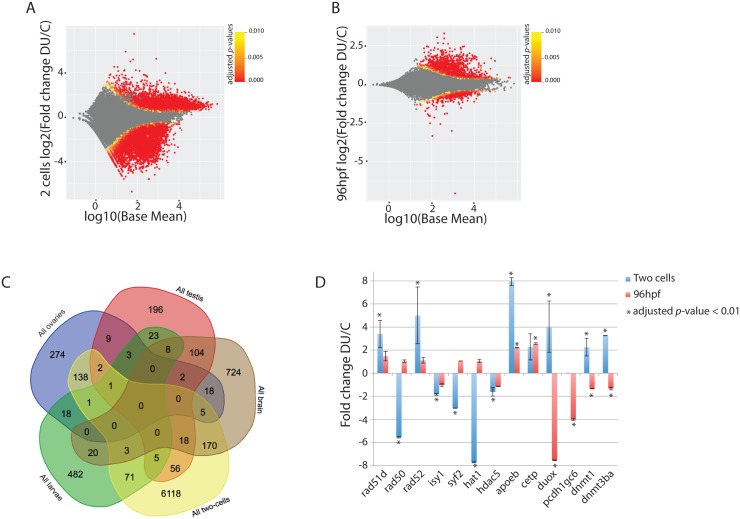
Differential expression analysis in two-cells stage embryos and 96 hpf larvae obtained from DU-exposed adult fish.(A) MA-plot at the two-cells stage. (B) MA-plot at 96 hpf. (C) Five-ways diagram of all genes regulated in adult brain, testis, ovaries and in the progeny of DU-exposed fish at two-cells stage and 96 hpf. (D) Examples of expression changes in the progeny of DU-exposed fish of genes involved in DNA repair (rad51d, rad50, rad2), splicing (isy1, syf2), chromatin remodelling (hat1 and hdac5), lipid transport (apoeb, cetp), oxidative stress (duox) and cell adhesion (pcdh1gc6) (all adjusted p-values (FDR) < 0.01; error-bars represent the standard deviation to the mean).